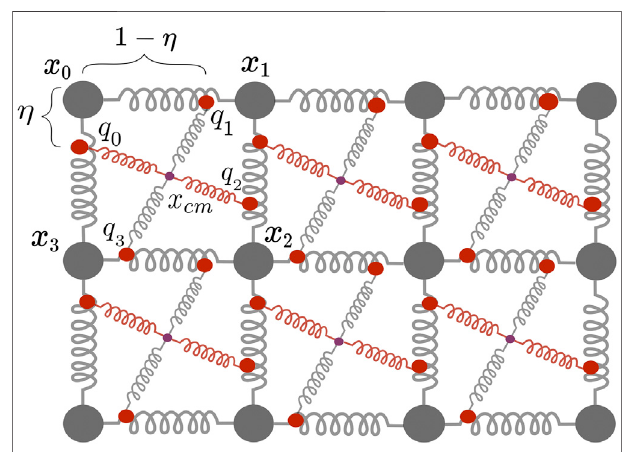
FIGURE 3 | Two dimensional mass-spring damper system with one activespringmodelling fi breorientation(red)andonepassivespring(gray),the centre of mass x cm , the four points of attachment q i to the structural springs and the orientation parameter η .